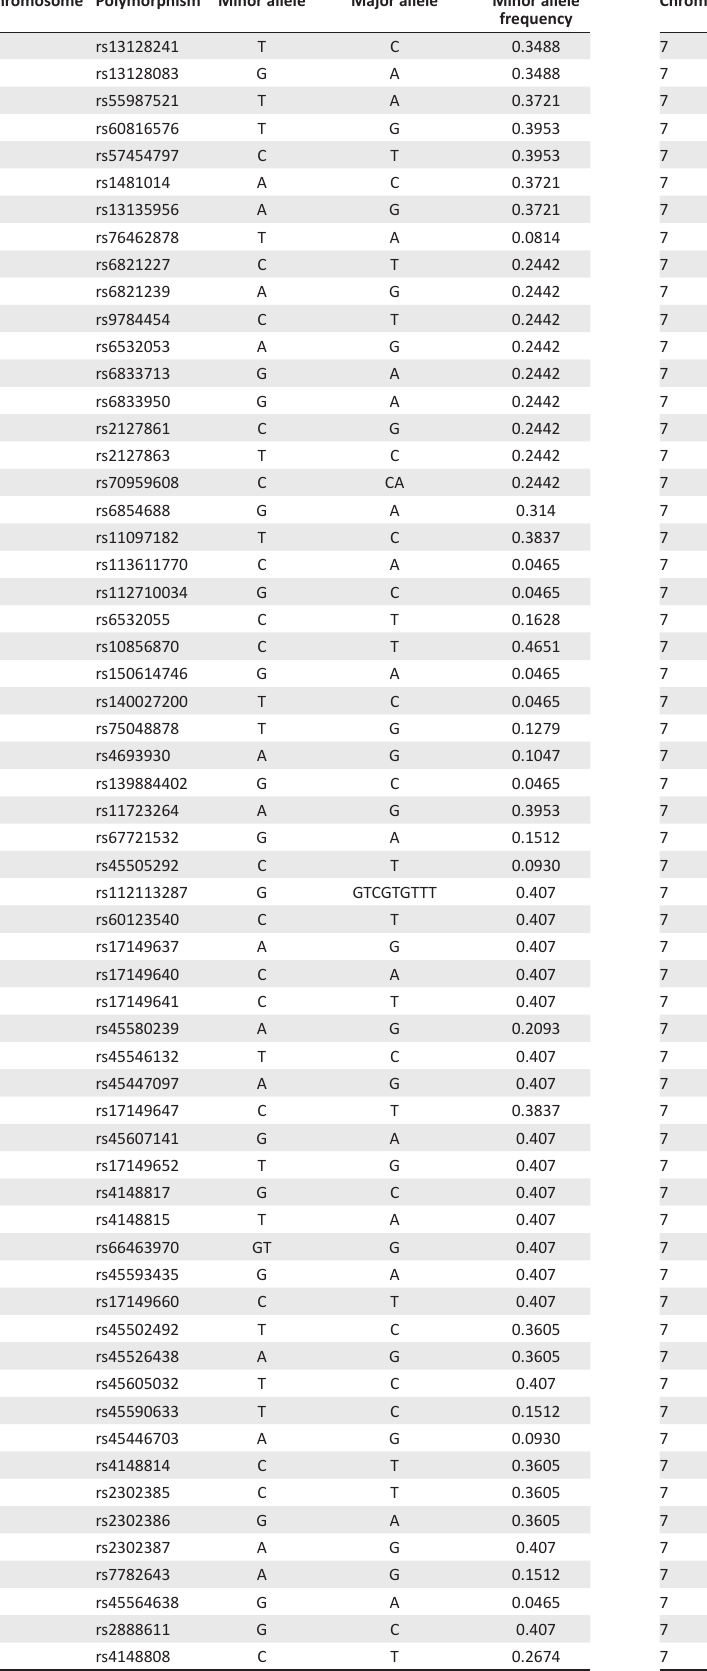
Table 1-A1 (Continues...): Minor allele frequencies for 1846 polymorphisms in 43 black South Africans. Chromosome Polymorphism Minor allele Major allele